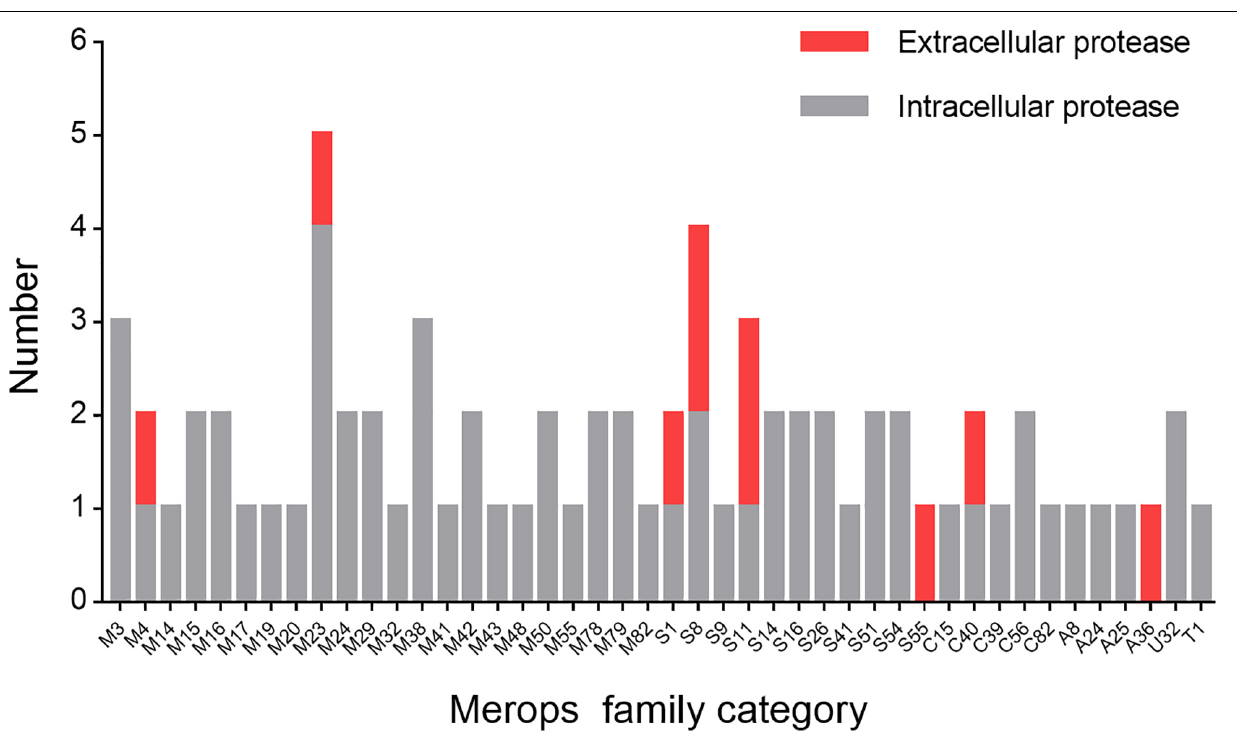
FIGURE 3 | Number of the proteases of strain 1A02591 in each Merops family. The number of proteases with a predicted signal peptide is shown in red and the number of proteases without a predicted signal peptide in